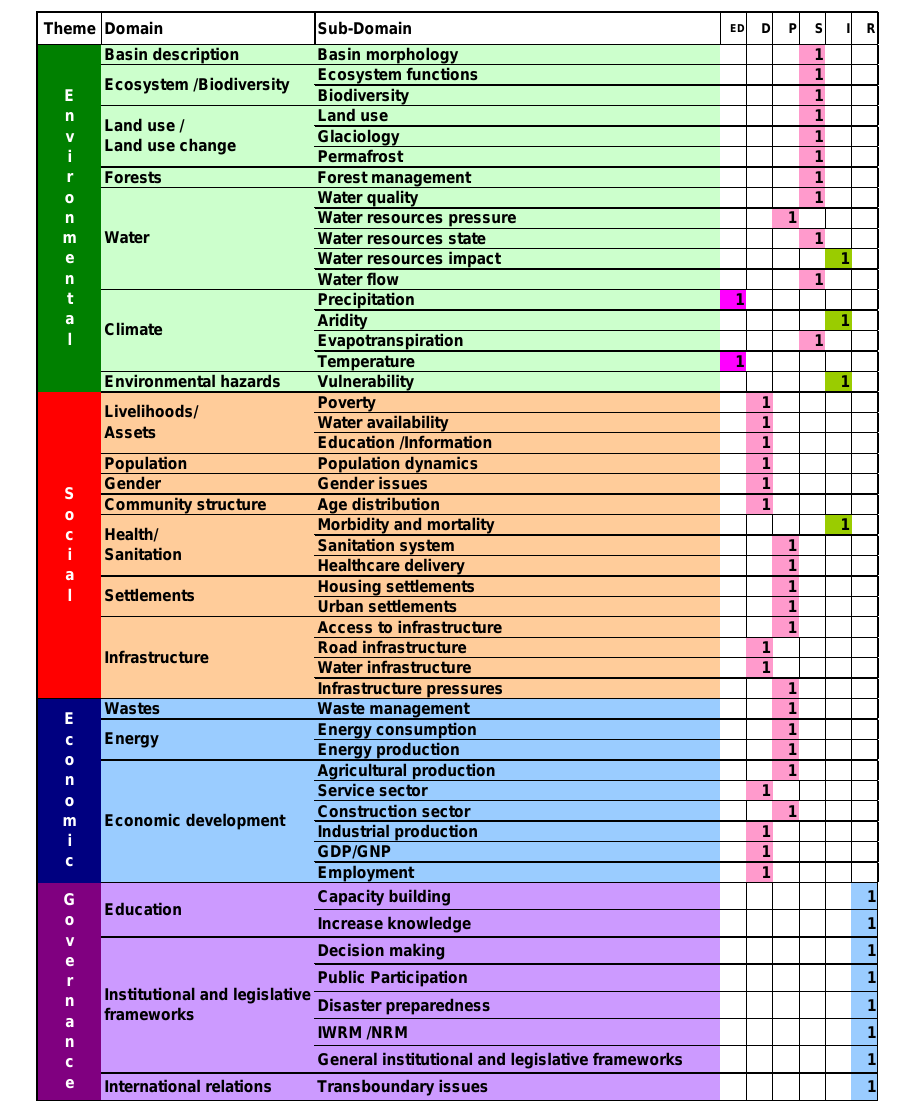
Table 1. Integrated Indicator Table (Themes, Domains, Sub-domains) and allocation to DPSIR scheme.